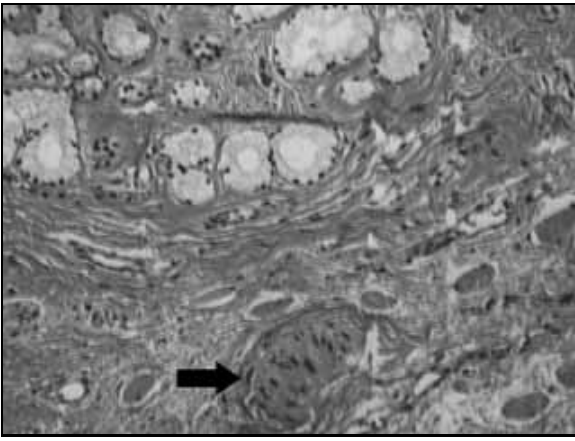
Figure 5 – Nerve fiber (marked) on lesion’s periphery near muscle fibers and small blood vessels (HE, magnification 100×) HE: hematoxylin and eosin.